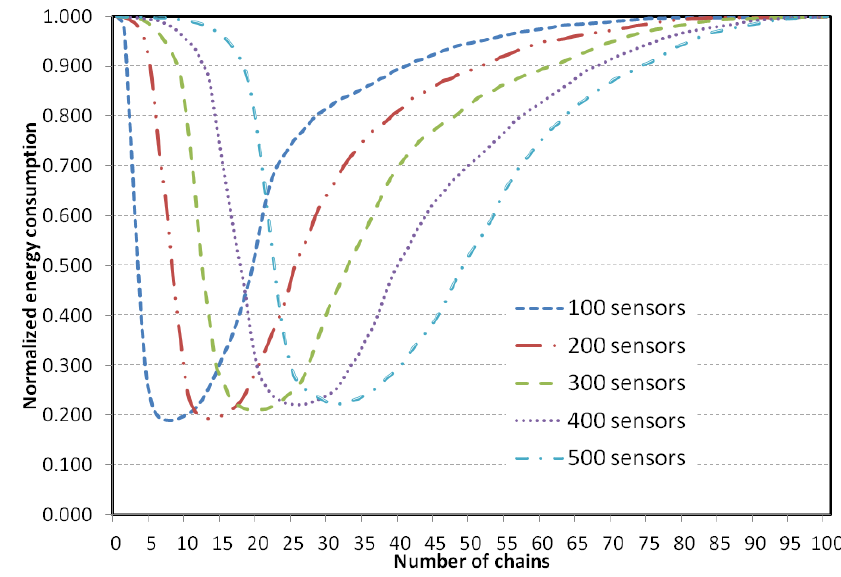
Figure 9. Normalised total system energy dissipated versus number chains